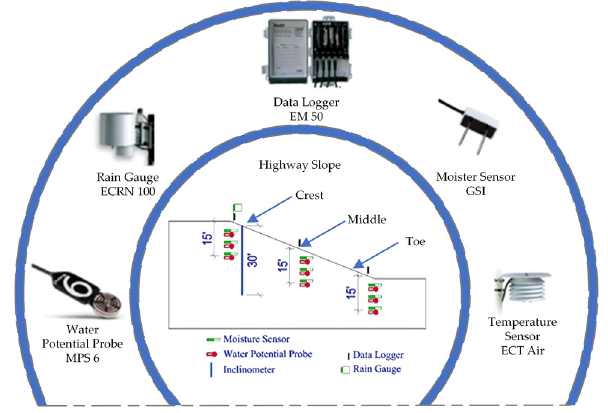
Figure 3. Instrumentation layout at each HWS and Image of the Individual Sensors.